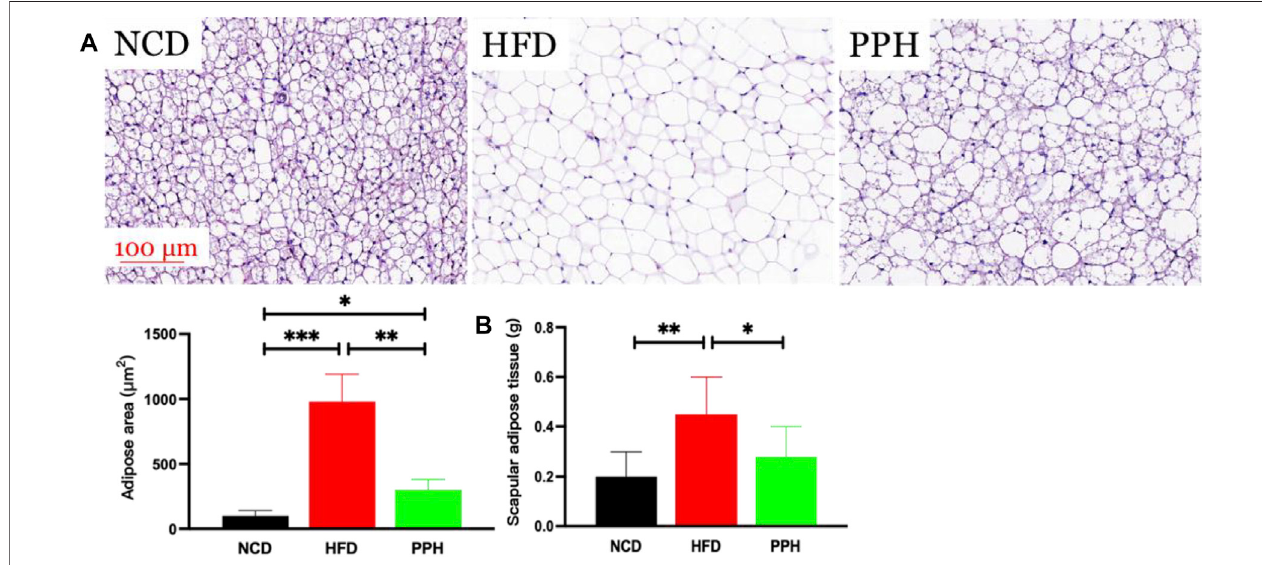
FIGURE5| PPHalleviatedscapularfatturnedintoWATconversioninscapula.H&Estainingofscapularadiposetissue (A) andscapularadiposetissueweight (B) . * p < 0.05, ** p < 0.01, and *** p < 0.001.